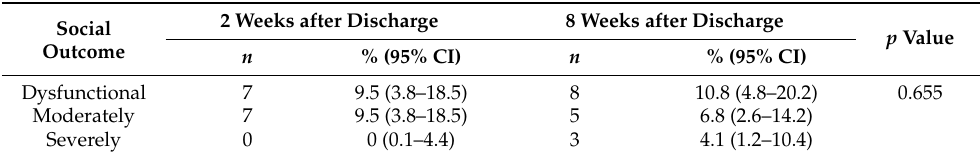
Table 4. The proportion of family members with perceived family dysfunction at 2 and 8 weeks after discharge of their relatives with COVID-19 from the study sites ( n = 74).